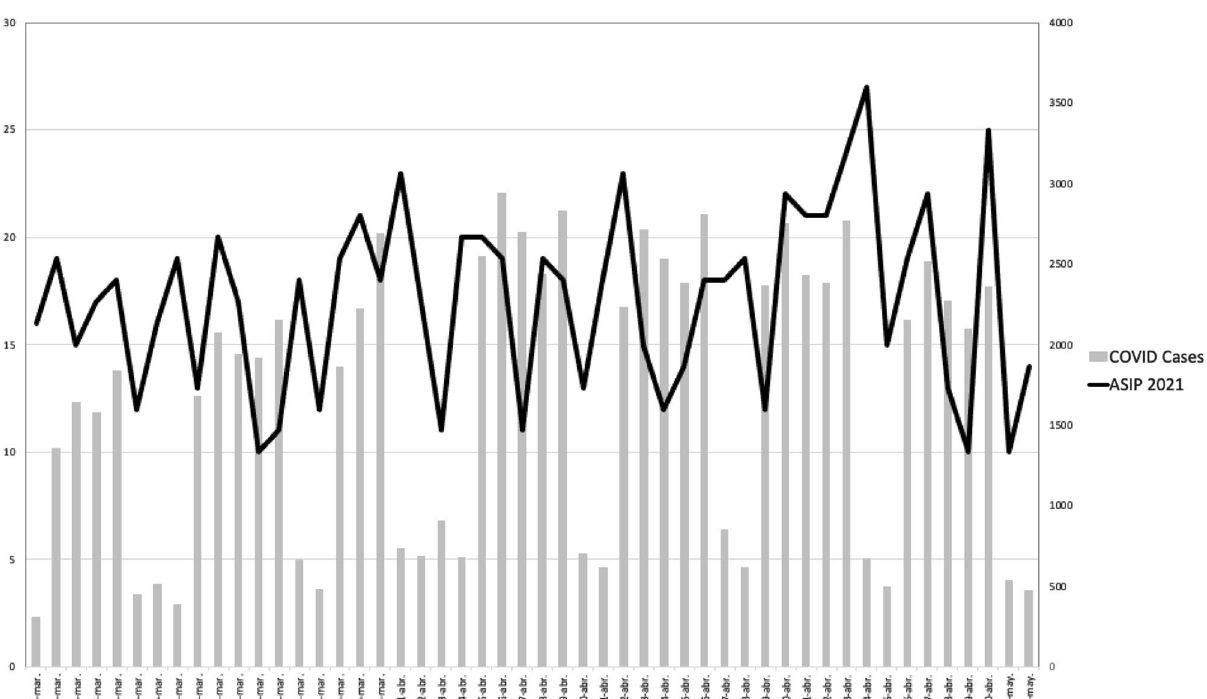
Figure 3. Relation between daily COVID and ASIP cases in